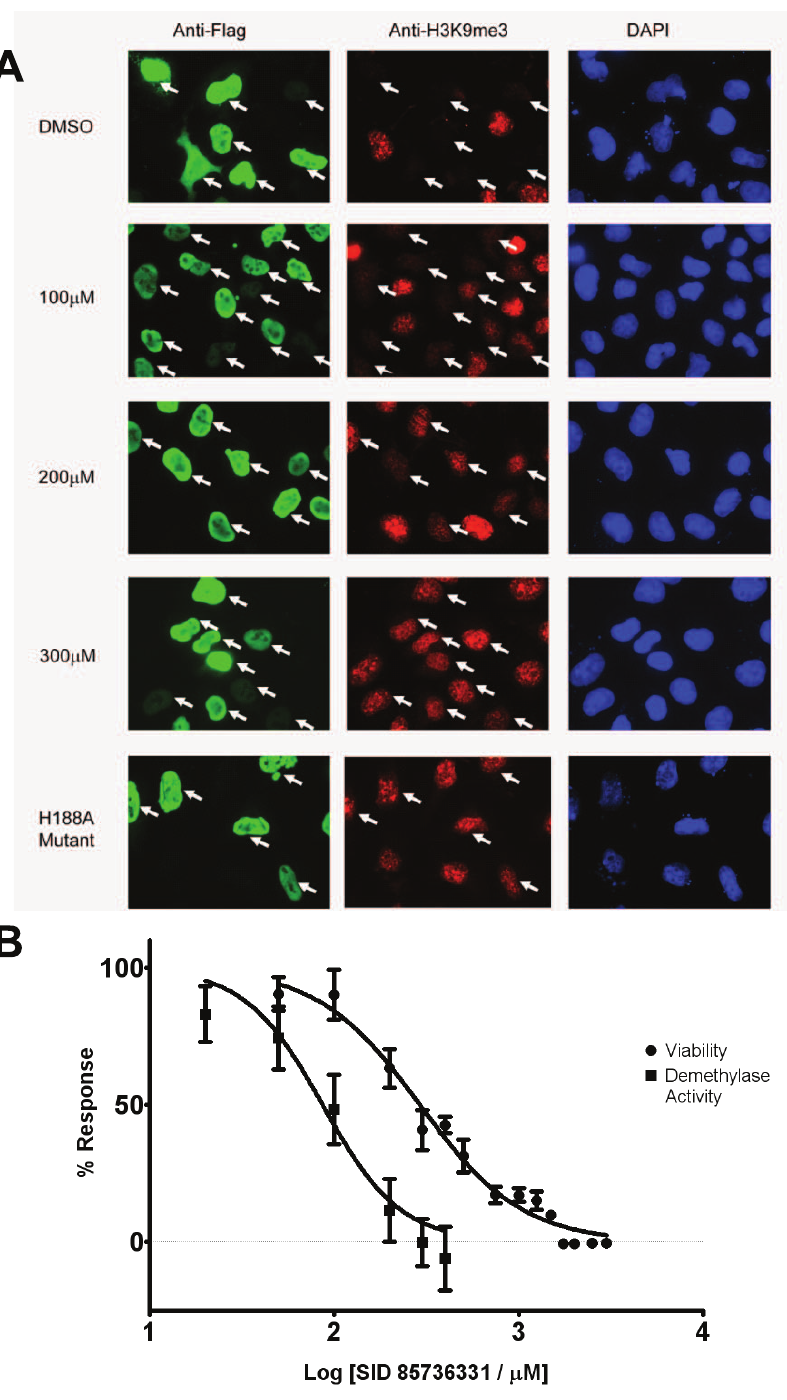
Figure 5. 5-Carboxy-8-HQ (SID 85736331) increases H3K9me3 levels in HeLa cells through inhibition of JMJD2A. ( A ) Indirect immunofluorescence with anti-Flag (green), anti-H3K9me3 (red), and DAPI staining (blue) in HeLa cells overexpressing Flag-tagged JMJD2A. DMSO solvent treatment has no effect on JMJD2A demethylase activity (white arrows) while increasing concentrations of 5-carboxy-8-hydroxyquinoline treatment (100 m M to 300 m M range shown) resulted in gradual increases in H3K9Me3 levels. The JMJD2A H188A enzymatic mutant does not affect H3K9Me3 levels when overexpressed. ( B ) Quantitation of H3K9me3 levels is shown as squares ( & ). Standard deviations are derived from biological triplicates at inhibitor concentrations of 20 m M, 50 m M, 100 m M, 200 m M, 300 m M, and 400 m M treatments. Cytotoxicity ( 100 m M, 200 m M, 300 m M, 400 m M, 500 m M, 750 m M, 1 mM, 1,25 mM, 1.5 mM, 1.75 mM, 2 mM, 2.5 mM, and 3 mM.